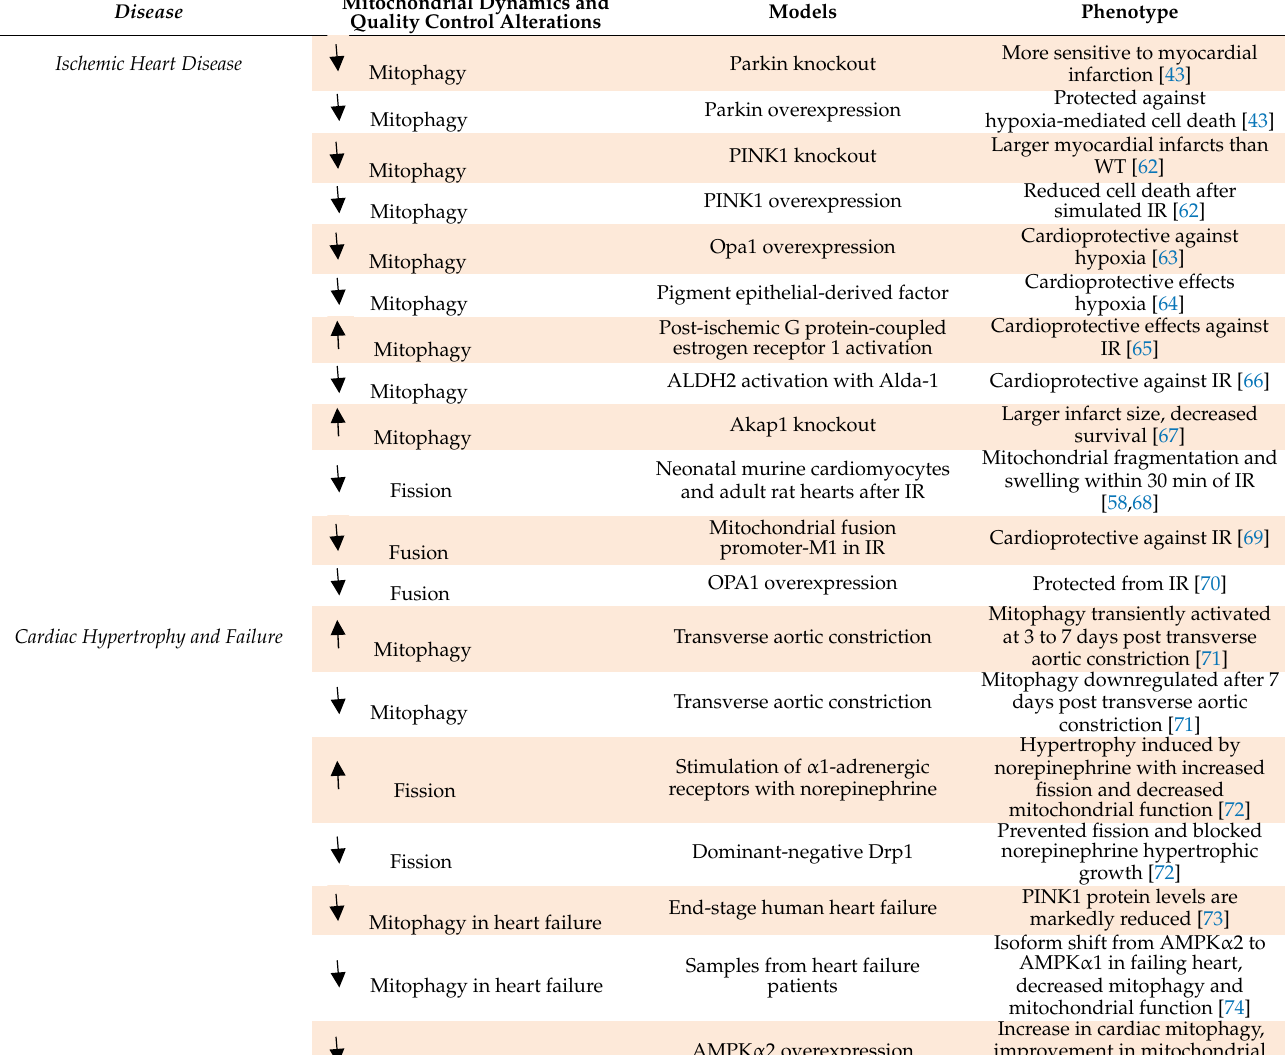
Table 1. Mitochondria Quality Control Alterations in Cardiovascular Diseases. Mitochondrial Dynamics Disease